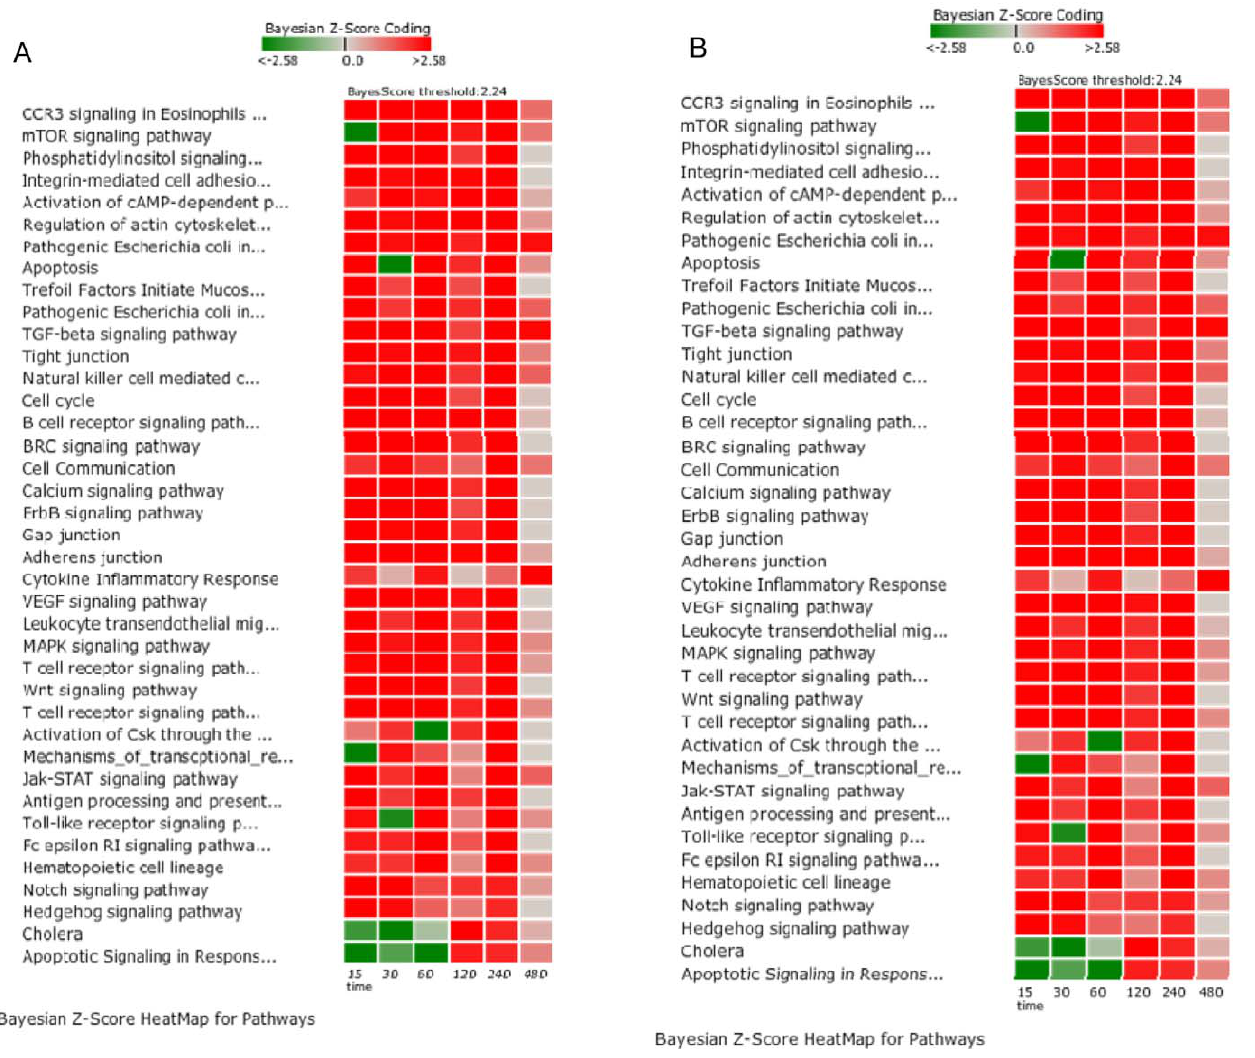
Figure 6. Temporal differences between pathways scores for wild type S.enterica serovar Typhimurium and the D sipA , sopABDE2 mutant. Pathway activation in wild type and mutant inoculated loops was compared and evaluated for temporal changes. Pathways activated in early time points (15 minutes, 30 minutes, and 60 minutes) were summarized (A) and pathways activated in late time points (120, 240, and 480 minutes) were summarized (B). Pathways were limited to the categories of cell mobility, cell communication, cell growth and death, infectious diseases, immune system, membrane transport, and signal transduction. The score magnitudes are shown as a gradient color from light to bright red for induced and from light to bright green for suppressed pathway